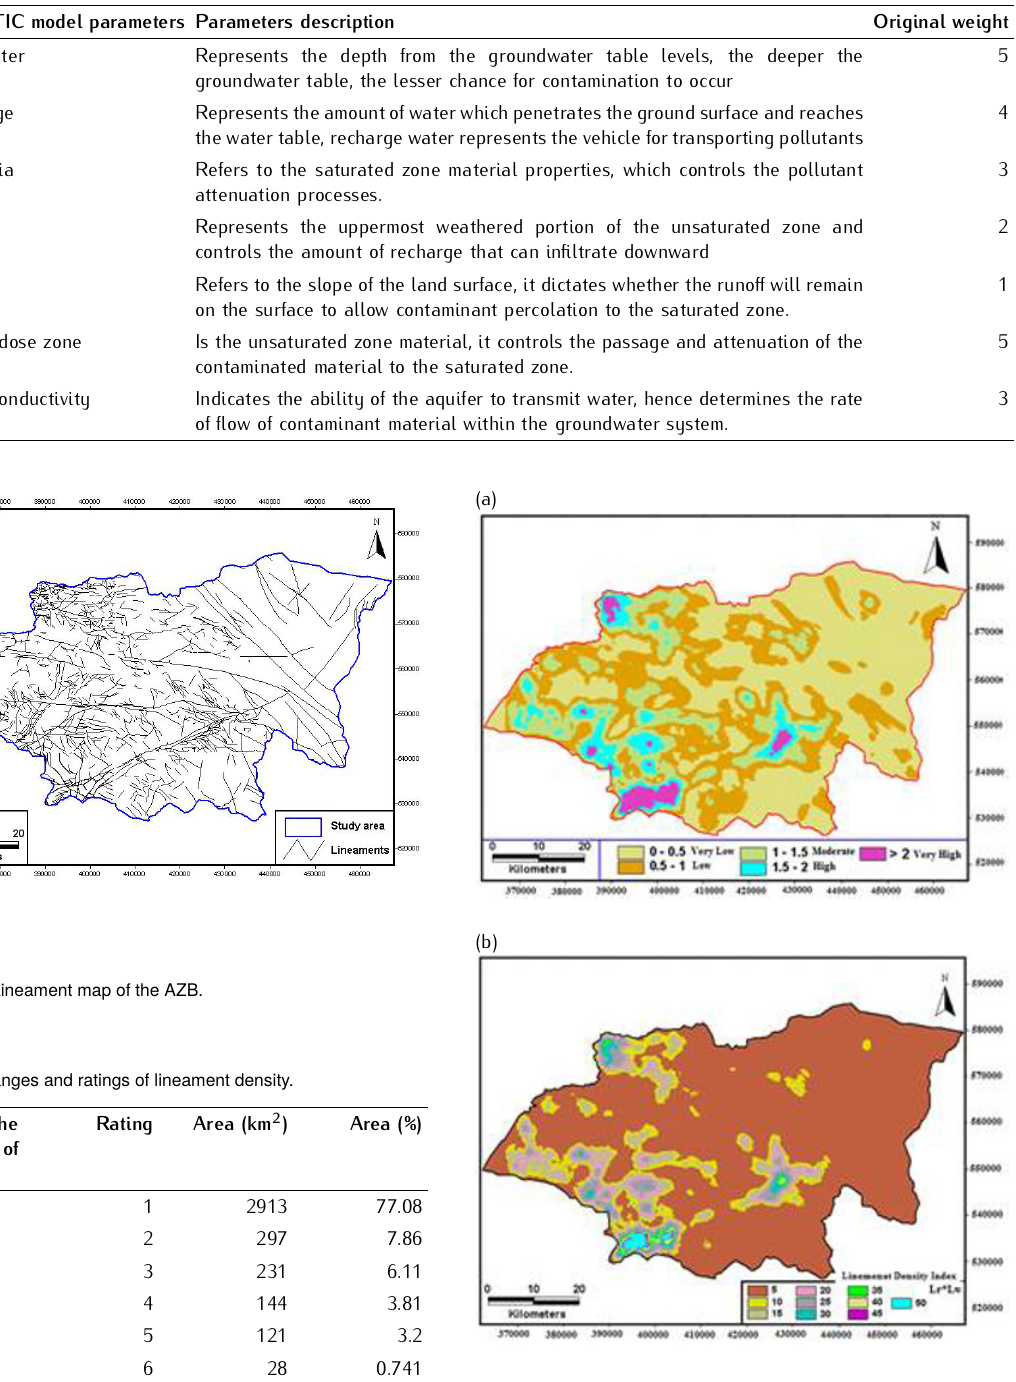
Figure 7. (a) Lineament density map of AZB; (b) Map of lineament density